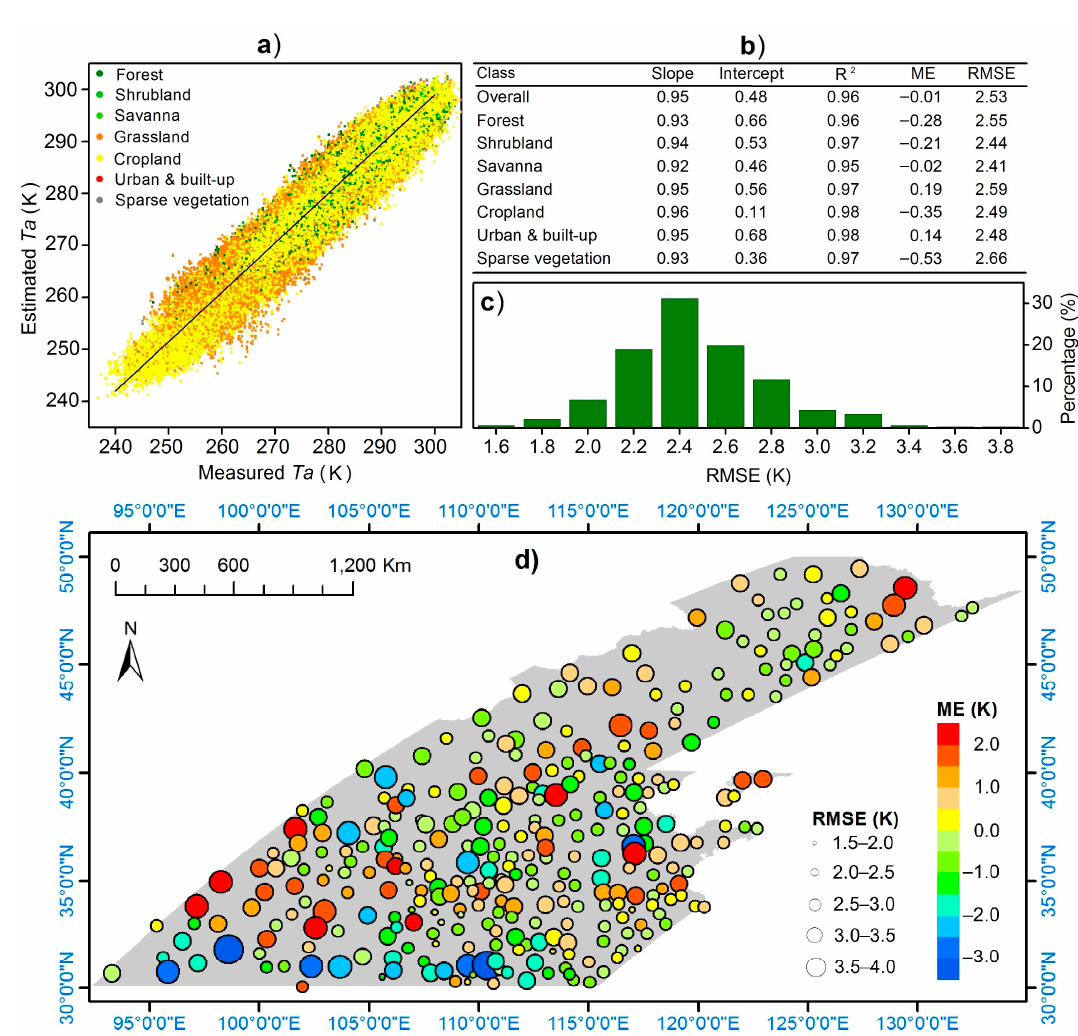
Figure 8. Error between the estimated and the measured Ta : ( a ) scatter plot; ( b ) statistics of error by land cover; ( c ) histogram of average RMSE for weather stations; and ( d ) spatial distribution of RMSE and ME at weather stations.